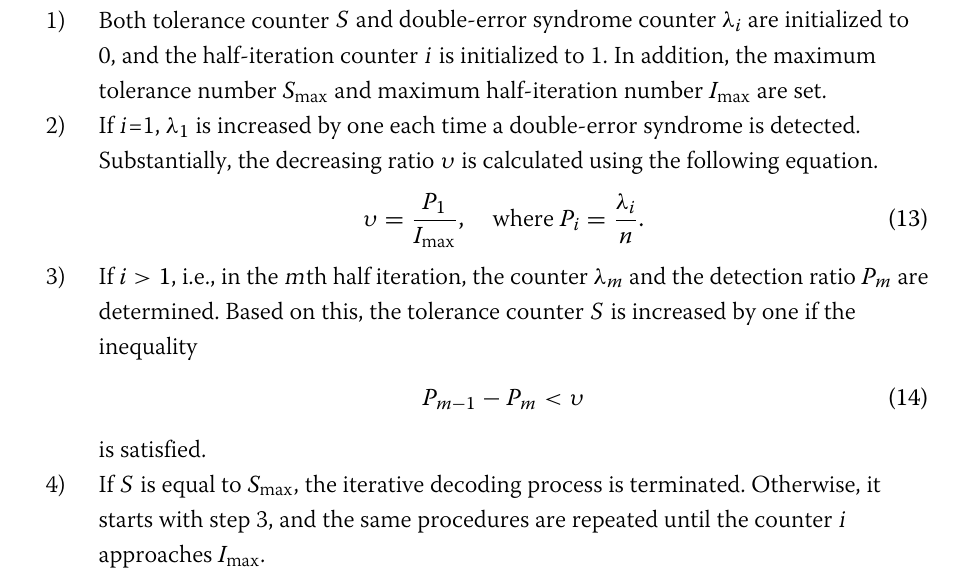
a more significant negative effect on the error correction. The detailed process of the proposed early termination algorithm is as